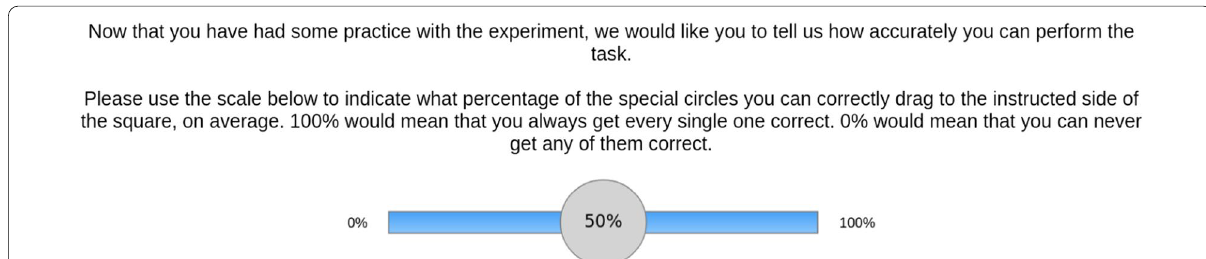
Fig. 4 Metacognitive Confidence Judgment. Note The metacognitive confidence rating provided us with our metacognitive confidence measure: After participants finished a series of practice trials, they rated their confidence in their ability to accurately remember the delayed intention of dragging the special circles to the respective edges. Participants performed these ratings once (prior to the start of the experiment) separately for the internal and external strategies. For the confidence rating after the forced‑external trials, participants received the alternate instruction ’Now that you have practiced doing the task using reminders, we would like you to tell us how accurately you can perform the task when you use this